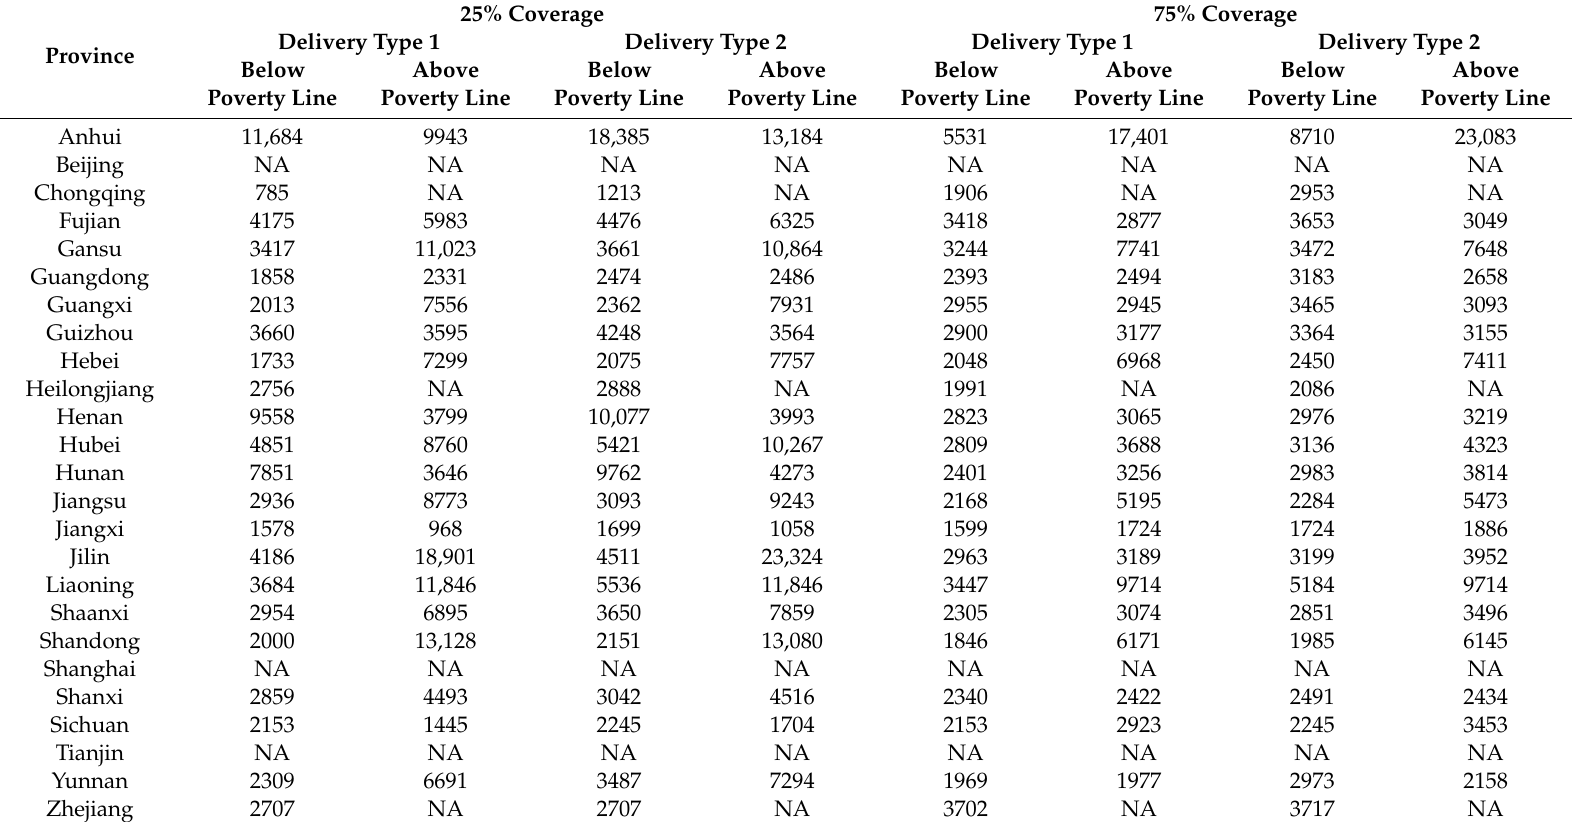
Table 2. Cost-e ff ectiveness of YYB program, by province and poverty status (Cost (¥) per stunting case averted).